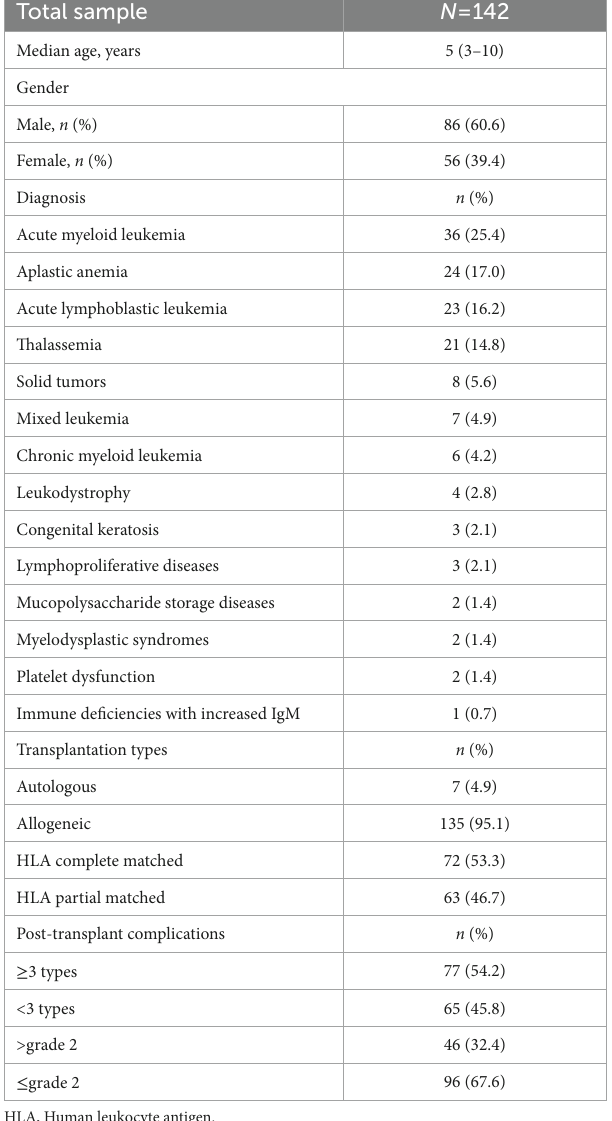
TABLE 1 Patient and transplant characteristics. TABLE 2 Direct health care costs with hematopoietic stem cell